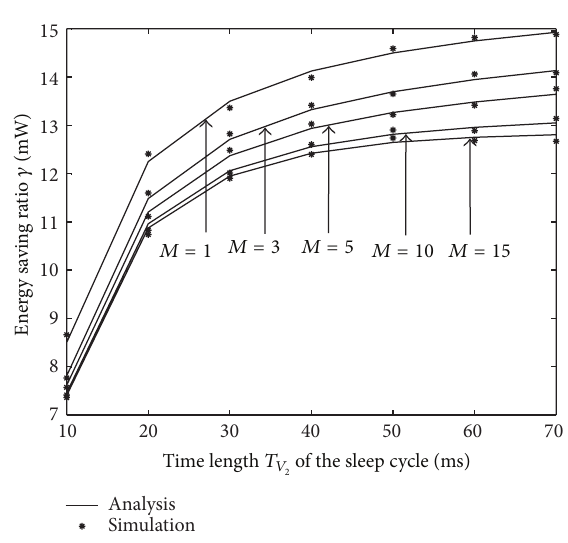
Figure 4: Energy saving ratio 𝛾 versus sleep cycle 𝑇 𝑉